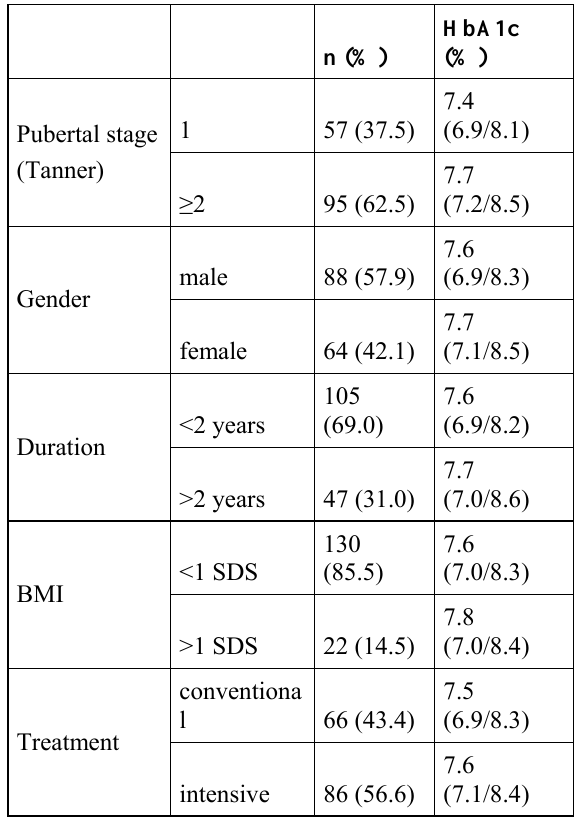
Clinical data, grouped by the pubertal stage, gender, diabetes duration, Body Mass Index and treatment modality, expressed as median (25 th /75 th